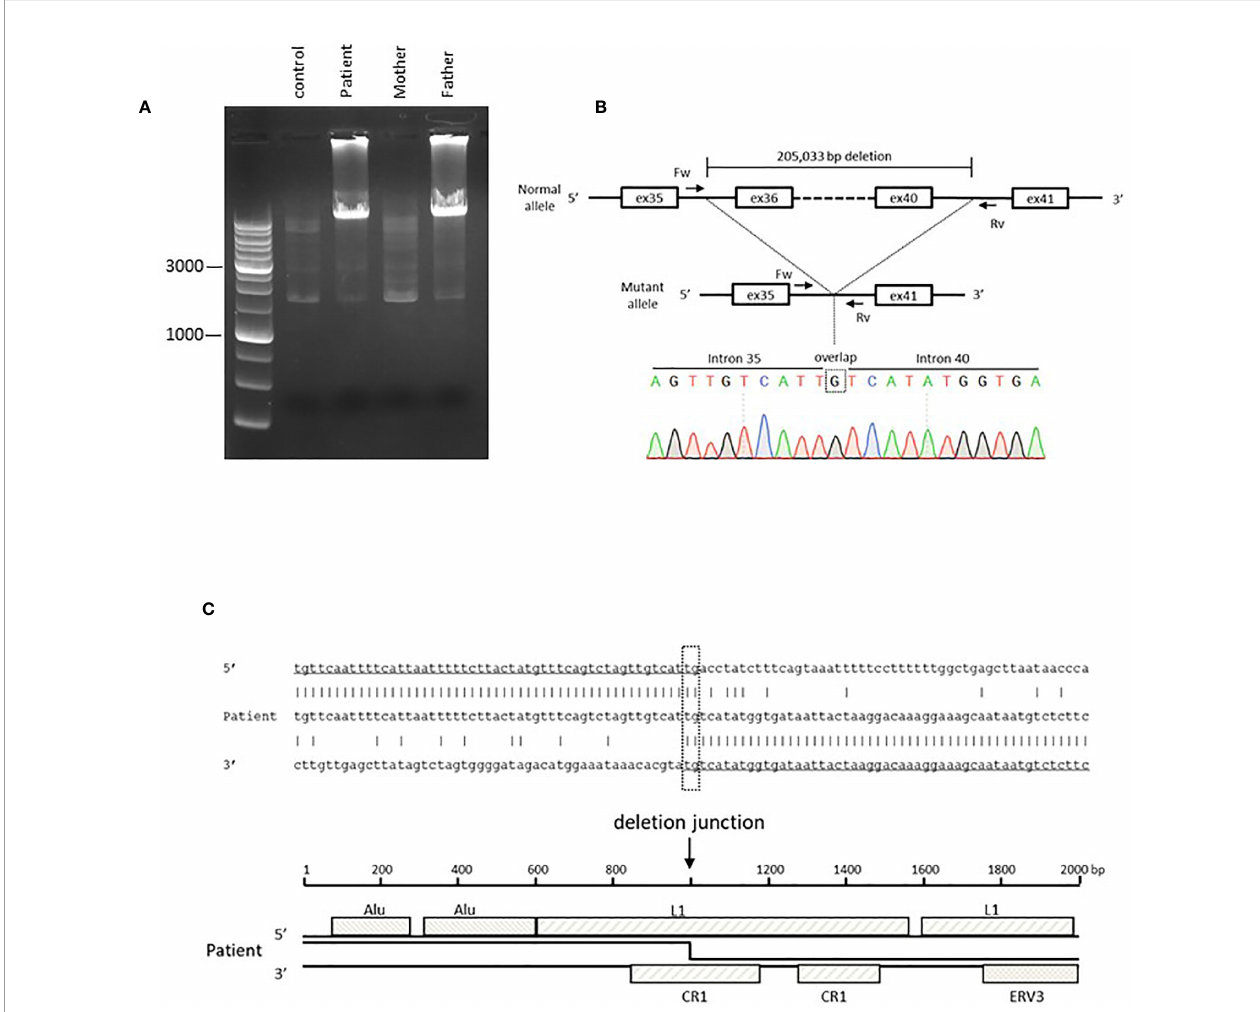
FIGURE 3 | Genetic analysis of a large heterozygous deletion in the LRBA gene. (A) Electrophoresis of the PCR product harboring the large deletion. The wild-type allele is too large for ampli fi cation. (B) Sanger sequencing of the breakpoint region. The 5 ′ breakpoint is located at chr4: 150,736,531 and the 3 ′ breakpoint at chr4:150,531,499 (GRCh38/hg38). This includes a one-nucleotide (G) overlap. (C) The sequence of the mutant allele and the reference sequences of the 5 ′ and 3 ′ breakpoint regions. The breakpoint region includes 2 bp (TG) of microhomology. Transposable element analysis showed that both breakpoints were located within LINEs. The 5 ′ breakpoint was within LINE1 (L1) and the 3 ′ breakpoint within Chicken repeat 1